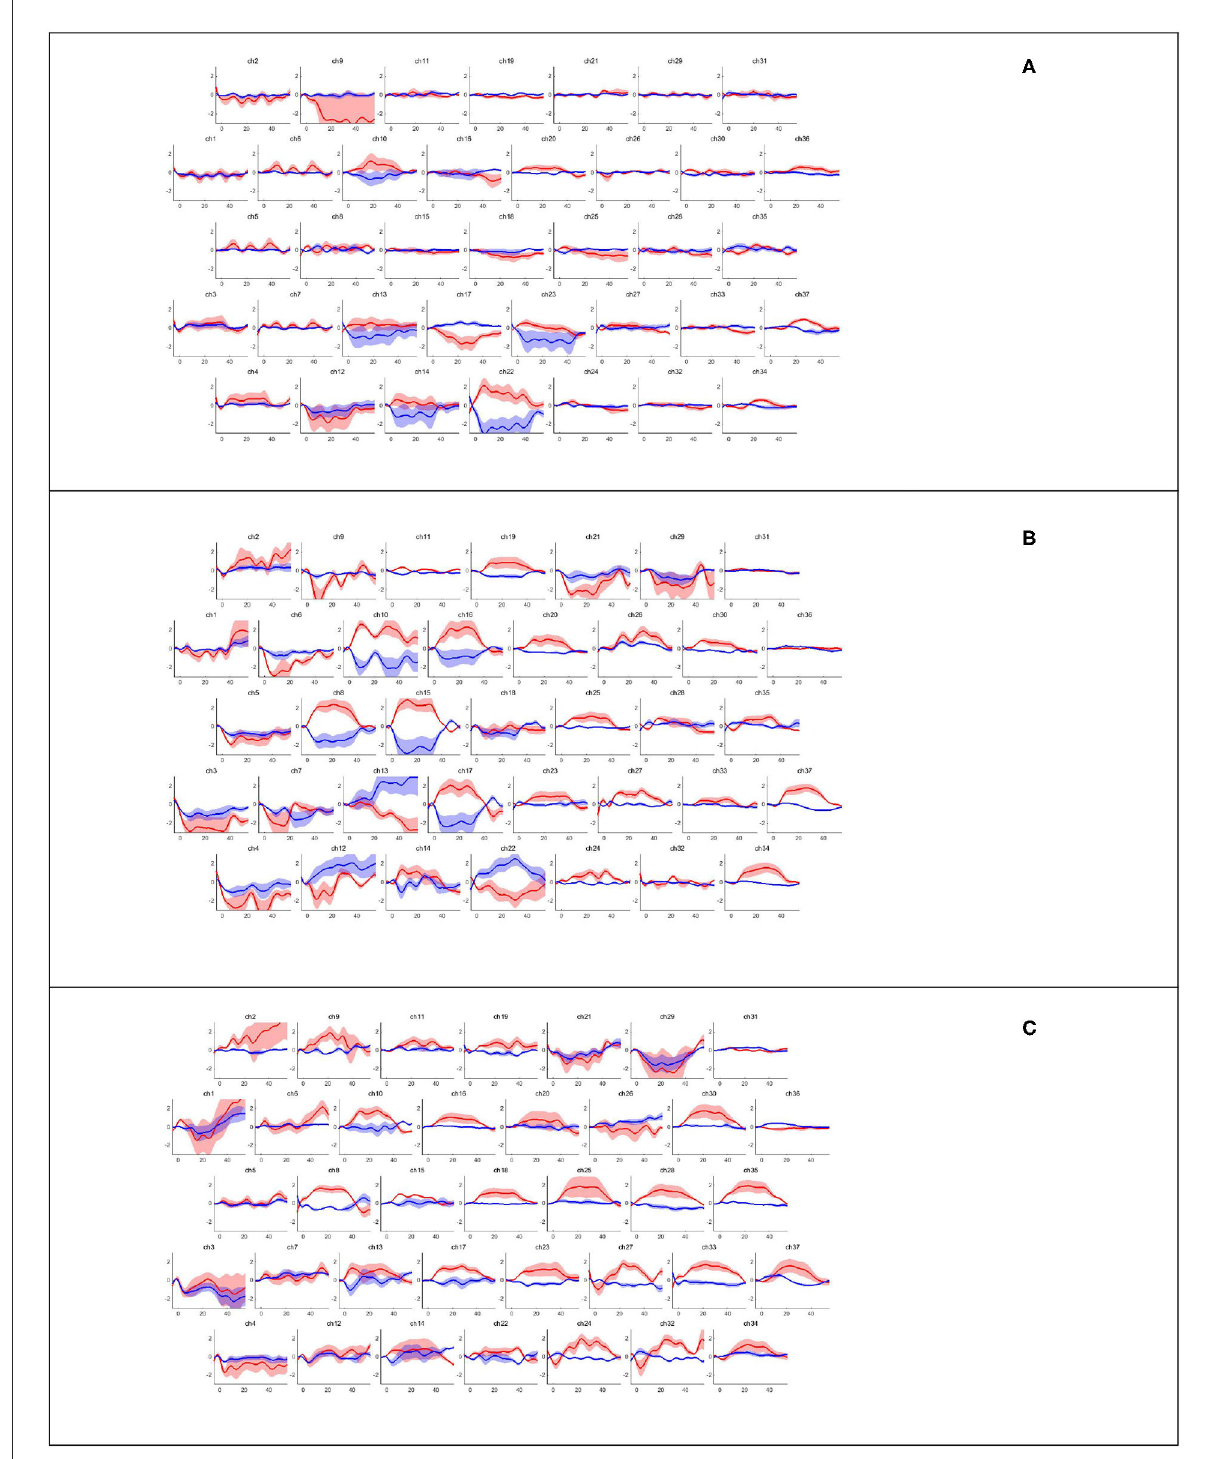
FIGURE3 Hemodynamic response corresponding to walking task-rest phase by channels. Block averaging of the hemodynamic response (hmrBlockAvg) was designed within the time range of − 5s to 55s; the baseline hmr level was 5s before the task began. The oxy-Hb and deoxy-Hb concentrations are indicated by the red and blue lines, respectively. (A) Healthy treadmill walking, (B) hemiplegic treadmill walking, and (C) hemiplegic treadmill walking with FES